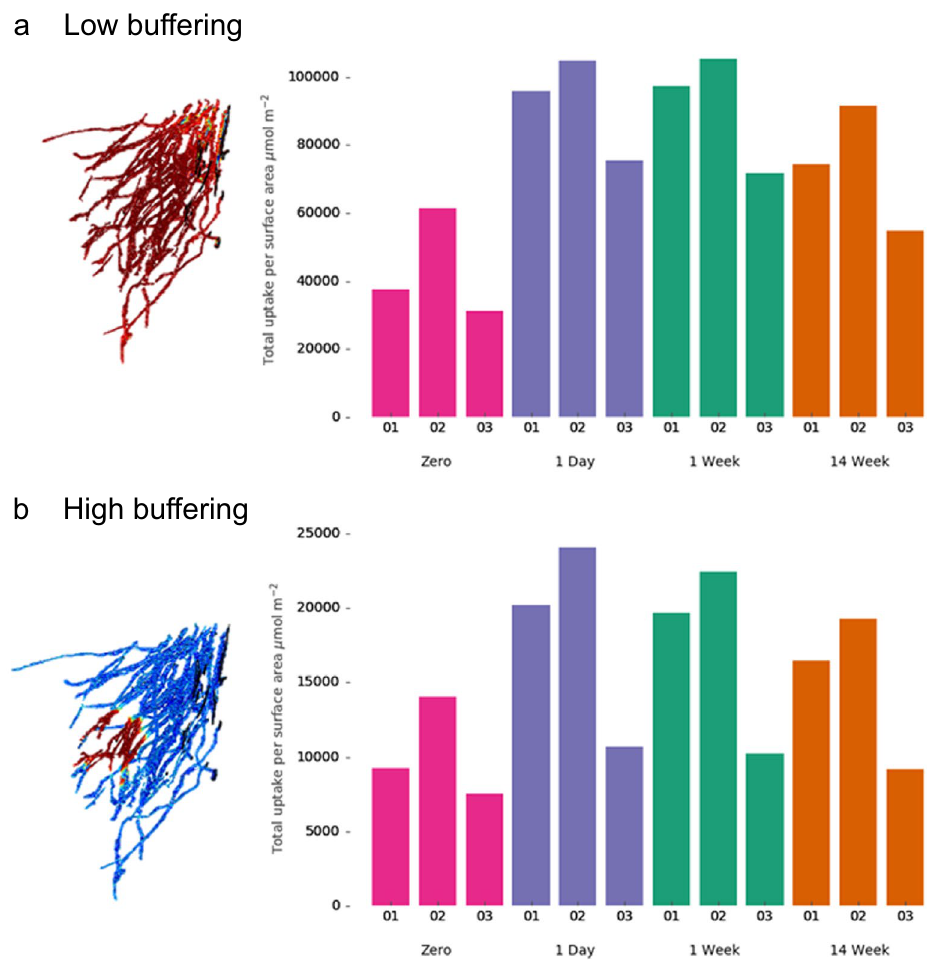
Figure 7. Simulated total P uptake per root surface area integrated over the whole experiment in ( a ) low buffering soil ( b ) high buffering soil. Different cases represent P dissolving from a pellet over 1-day, 1-week, and 14 weeks, and a case with no added P fertiliser (zero fertiliser) for three different root systems (samples 01, 02, 03). For visualisation purposes, root images show uptake rate at 43